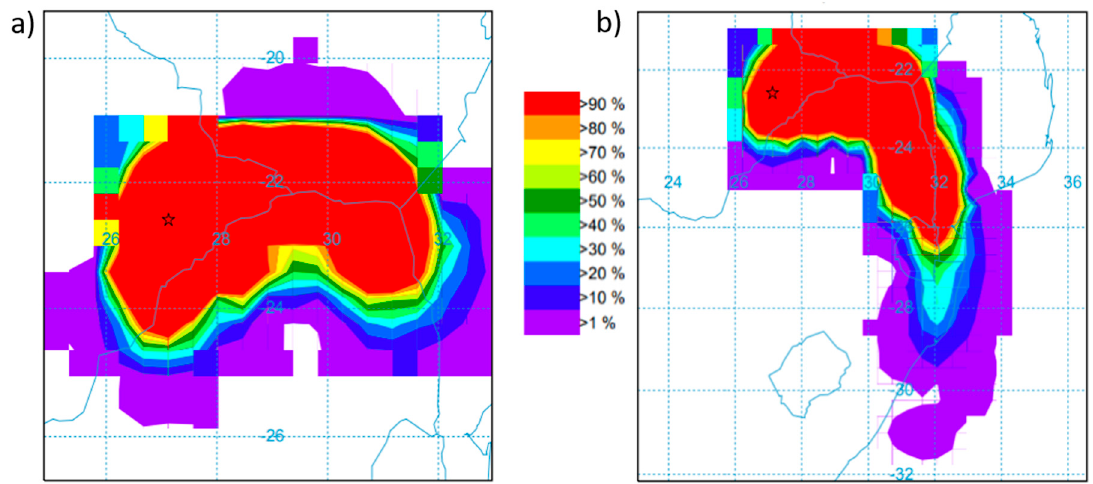
Figure 8. HYSPLIT back-trajectories for ( a ) the first half of the measurement period and ( b ) the second half of the measurement period (note that ( b ) spans a much larger area). The star symbol indicates the measurement location.